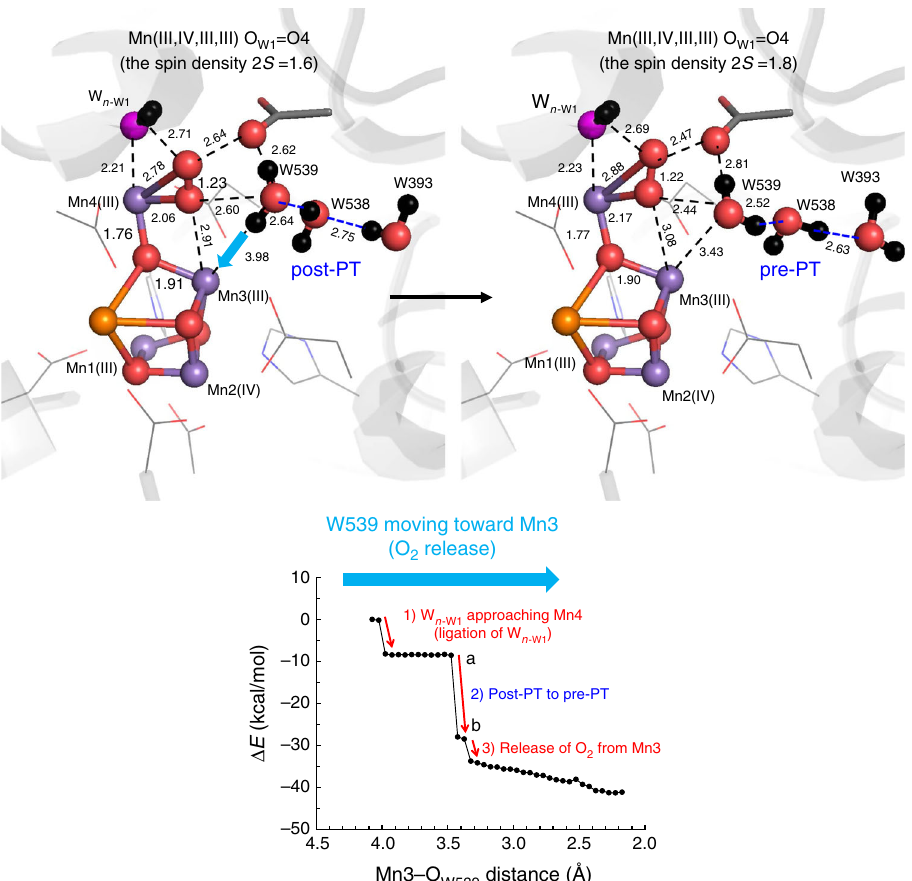
Fig. 7 The energy pro fi les when W539 approaches Mn3(III). As W539 approaches Mn3(III) (i.e., the Mn3 … O W539 distance was decreased), concertedly (1) W n -W1 approaches Mn4 (ligating to Mn4), (2) the H-bond pattern of the O4-water chain transforms from the post-PT to pre-PT pattern, and (3) O 2 releases from the Mn3 moiety. The total spin density 2 S is shown for O W1 = O4